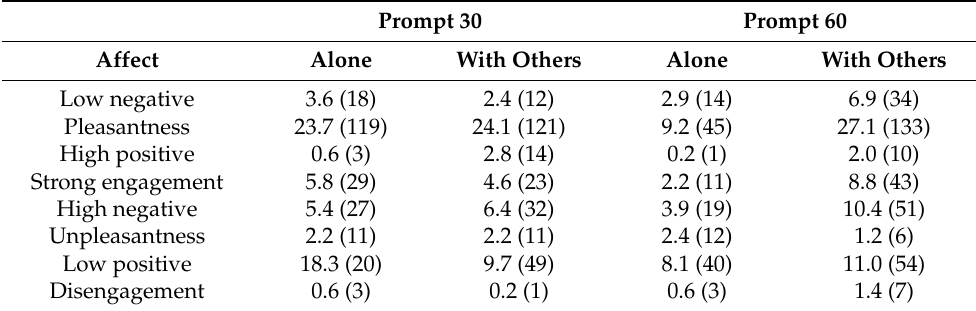
Table 1. Pooled chi-squared interaction response between mood (affect) and company (alone or with colleagues) across the 12 week